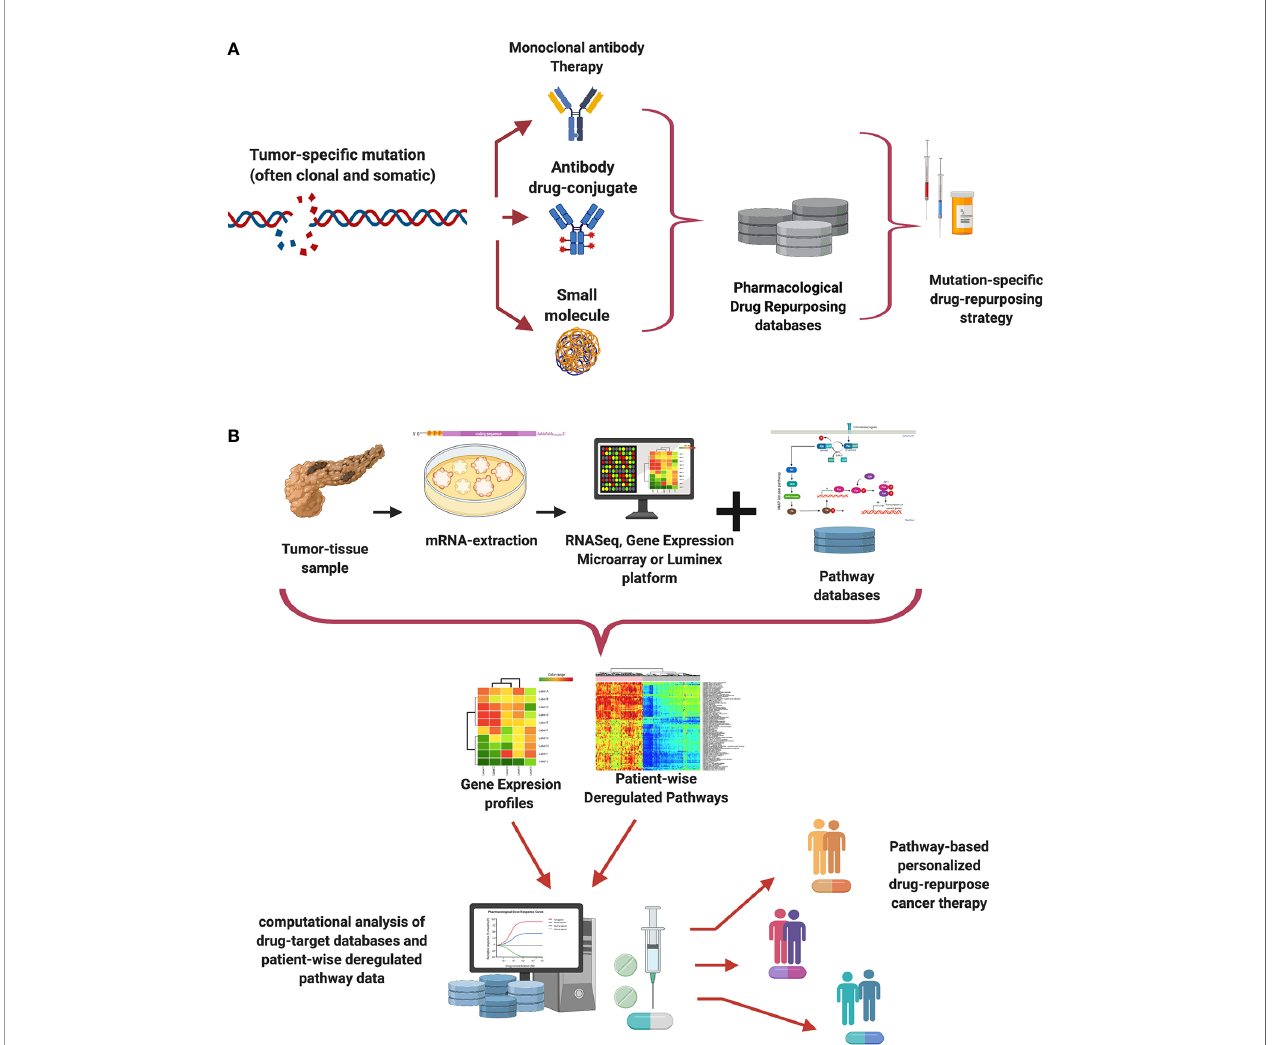
FIGURE 1 | Mutation-speci fi c and pathway-centric approaches to drug re-purposing. Panel (A) exempli fi es a simpli fi ed work fl ow for drug repurposing based on tumor mutation pro fi ling, Panel (B) shows one possible pipeline for drug repurposing based on pathway activities as proxied by gene expression